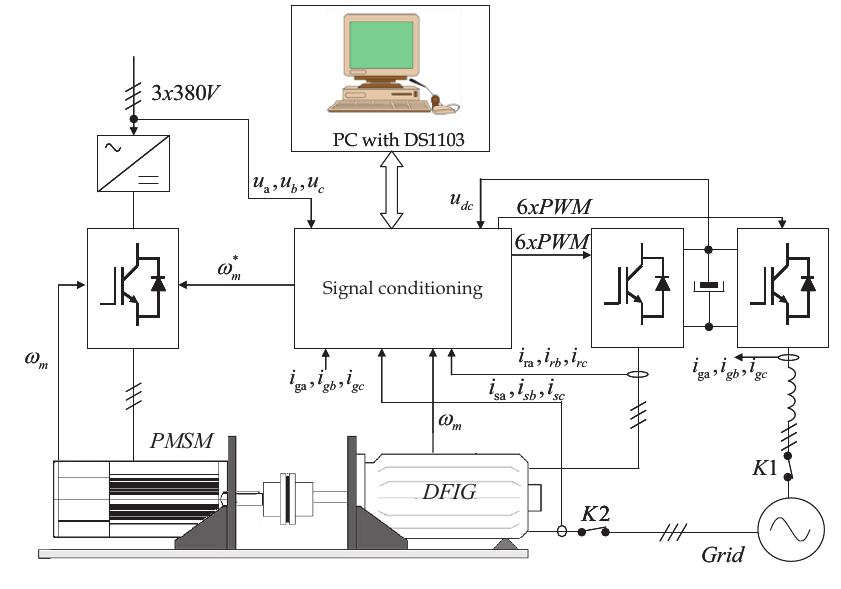
Figure 3. Block diagram of the DFIG wind turbine experimental platform.